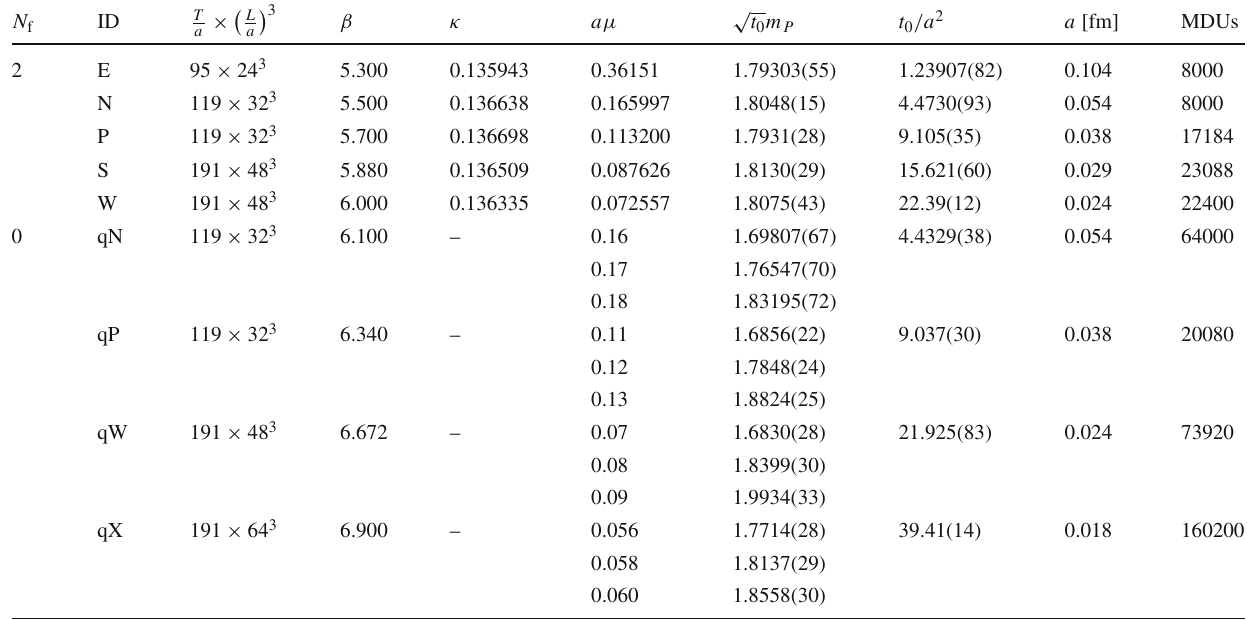
For the N f = 0 ensembles, we report the values of three different valence quark masses a μ . The temporal extent T is an , the critical hopping 0 odd multiple of a because open boundary conditions are applied in the temporal directions and the links pointing out of the lattice volume are